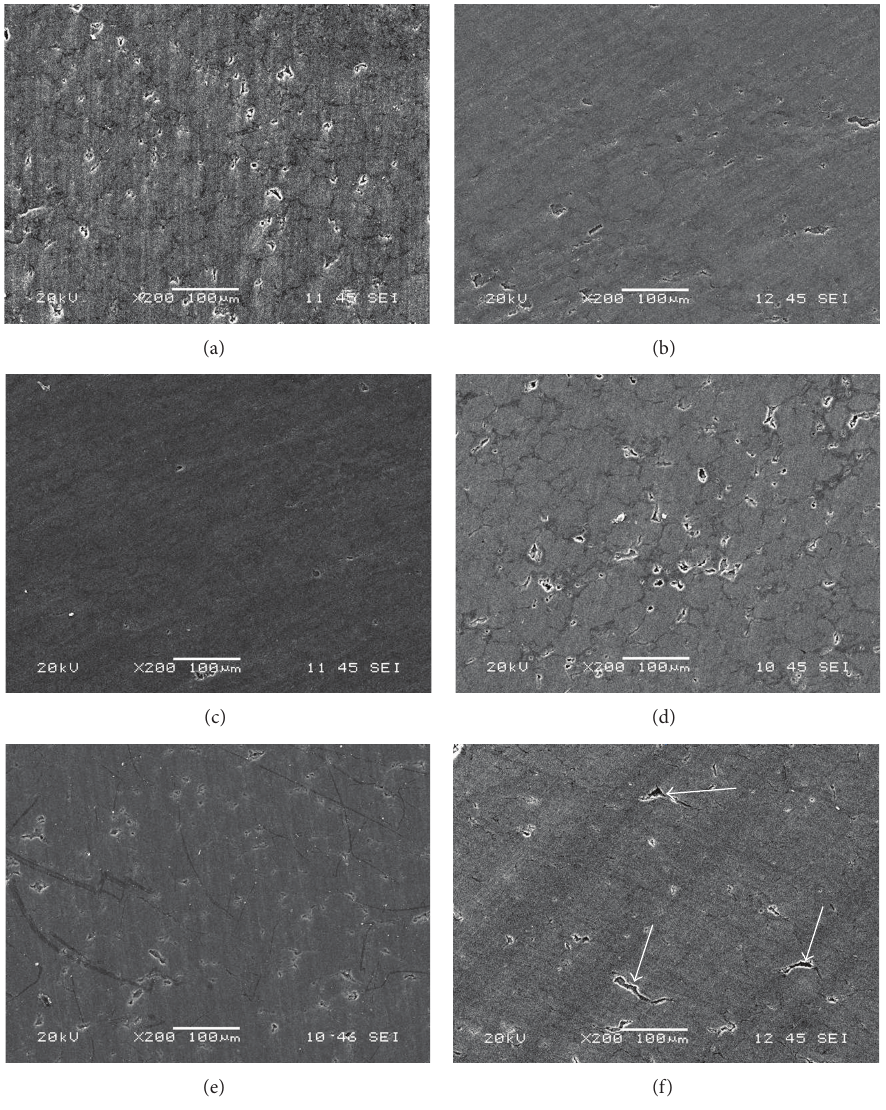
Figure 4: SEM micrographs of Al6061 + 1wt.% CNTs spark plasma sintered at (a) 400 ∘ C, (b) 450 ∘ C, and (c) 500 ∘ C and Al6061 + 2wt.% CNTs spark plasma sintered at (d) 400 ∘ C, (e) 450 ∘ C, and (f) 500 ∘